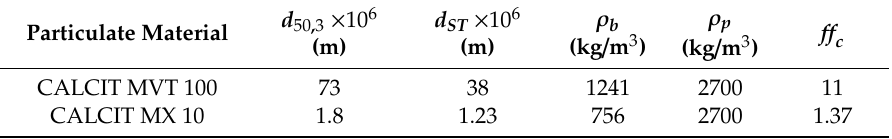
Table 2. Properties of the fine and ultra-fine particulate materials used in this study [15].